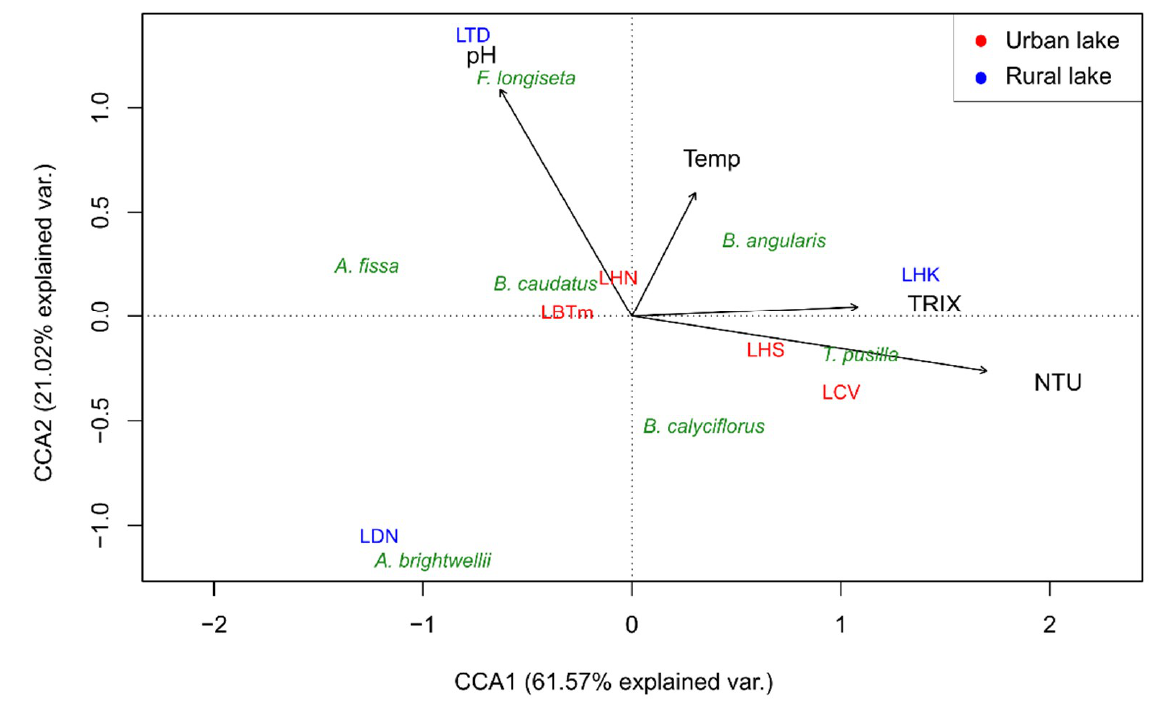
Figure 6. Canonical correspondence analysis of commonly found rotifer taxa and environmental variables in freshwater lakes in Da Nang (see Table 1 for the short codes of the sampling sites).